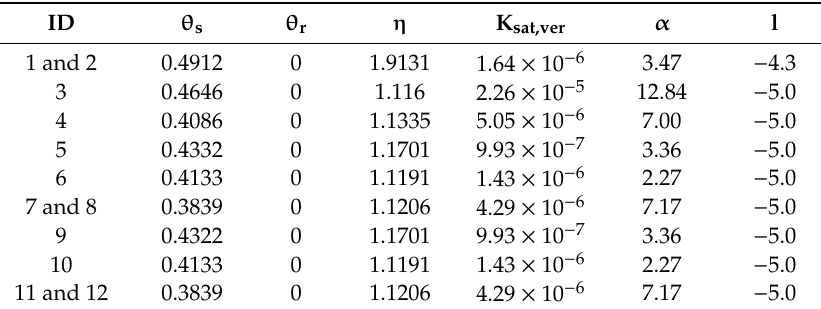
Figure 2. MOHID-Land input data: Manning coefficients ( a ); main land uses ( b ); crop coefficients ( c ); and soil data for horizons 1 ( d ), 2 ( e ), and 3 ( f ). Table 2. Soil hydraulic